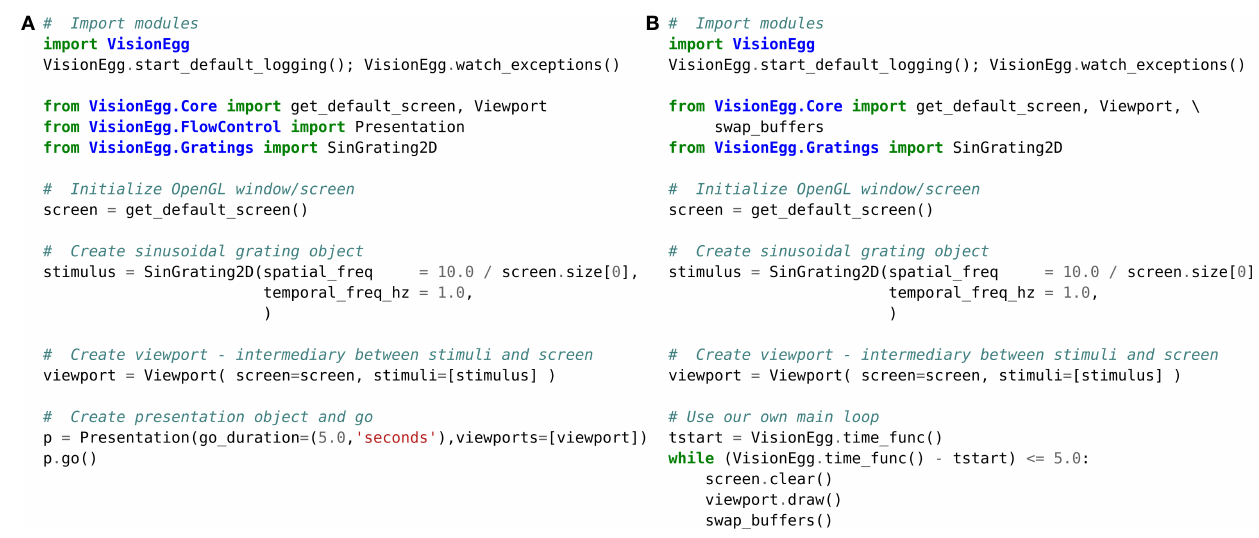
Figure 2 | Source code of simple Vision Egg program to draw a moving sinusoidal grating illustrating a simple but complete program. Two means of controlling the fl ow of execution are available, as described in Section “Mid-level Software Overview: Controlling Program Flow.” (A) Program fl ow is controlled by the Vision Egg’s Presentation class. (B) Program fl ow is explicitly specifi ed within the